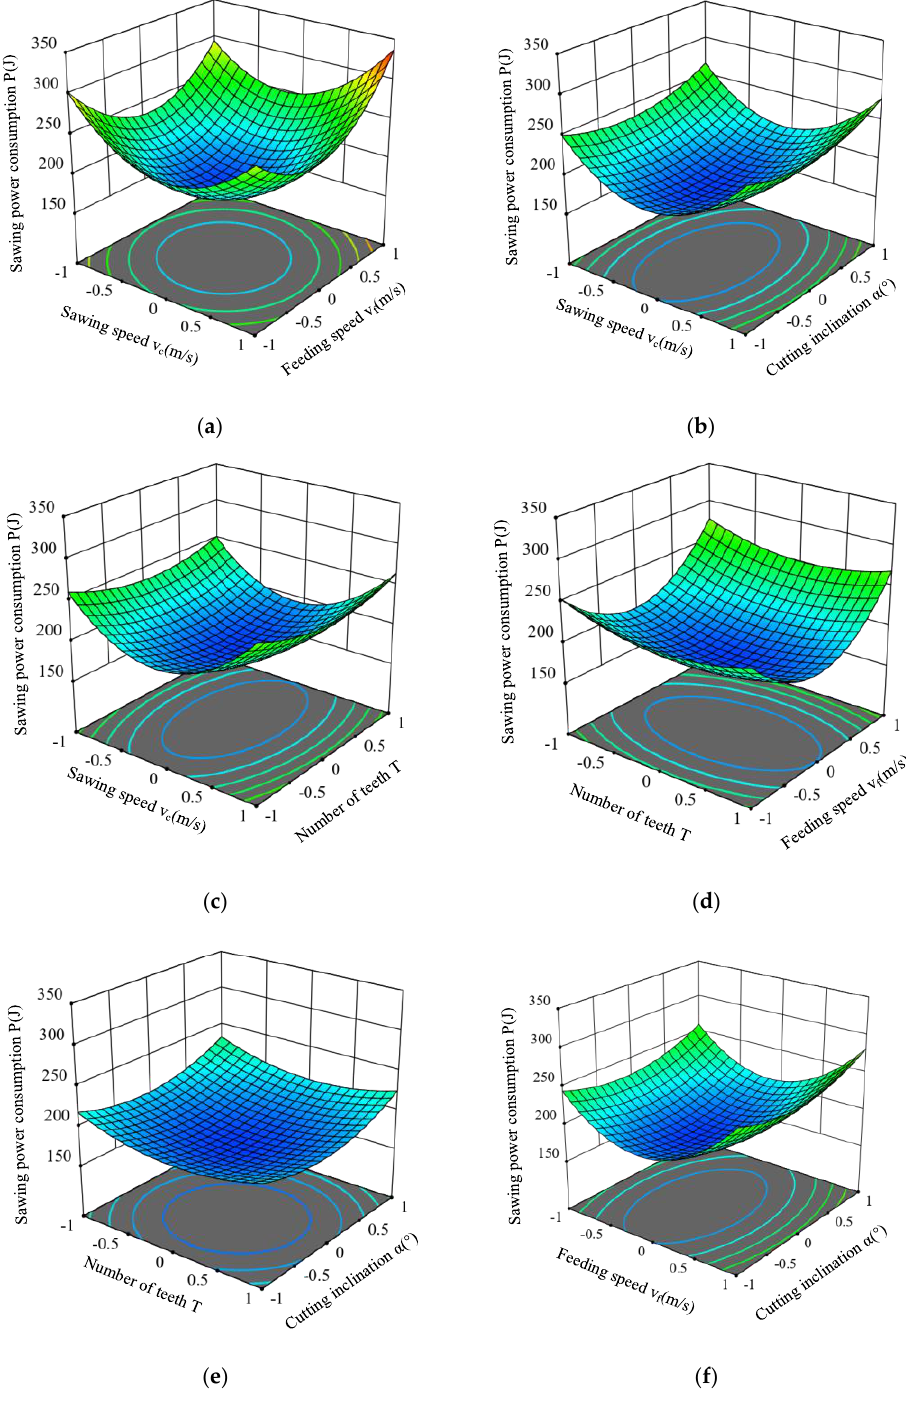
Figure 17. The influence of interaction factors on sawing power consumption. (( a ) P = f( 𝑣 𝑐 , 𝑣 𝑓 ,0,0); ( b ) P = f( 𝑣 𝑐 , 0 , α ,0); ( c ) P = f( 𝑣 𝑐 ,0,0, T ); ( d ) P = f(0, 𝑣 𝑓 ,0, T ); ( e ) P = f(0,0, α , T ); ( f ) P = f(0, 𝑣 𝑓 , α , T )).